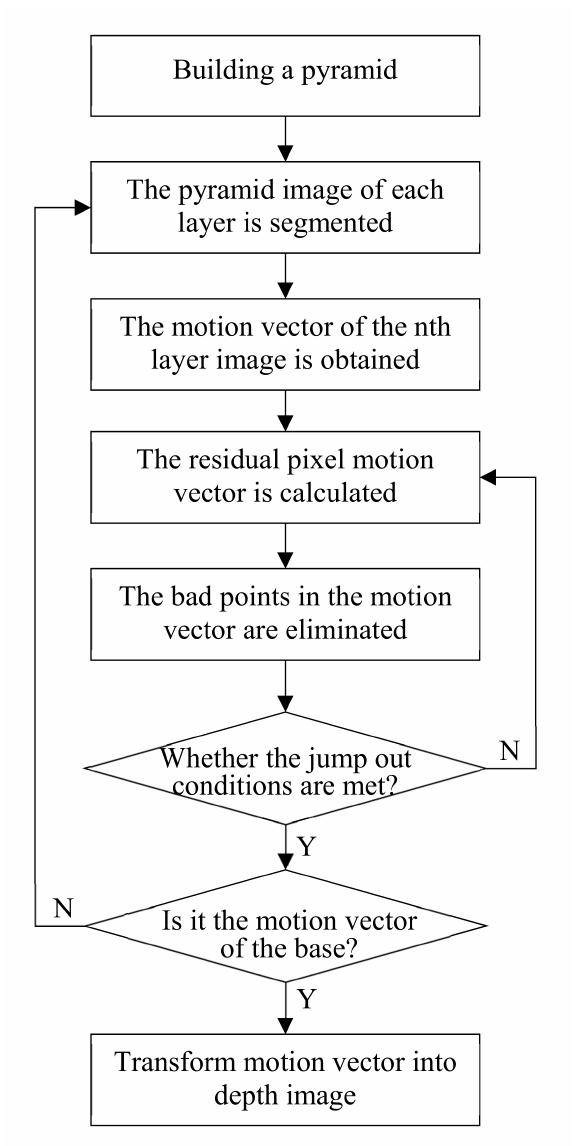
Figure 11. The pyramid Lucas-Kanade optical flow algorithm based on image